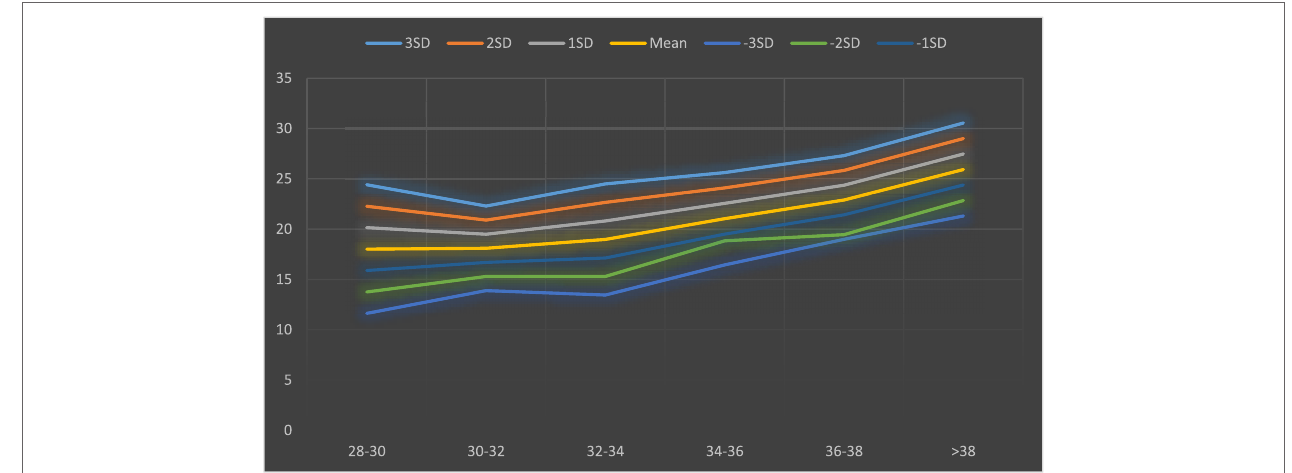
FigUre 1 | Mean and SD of penile length based on different gestational age of